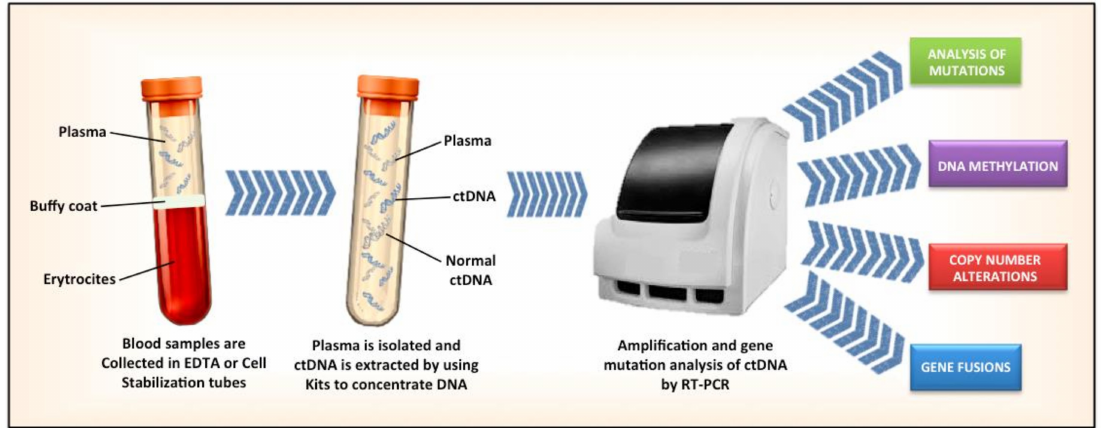
Figure 1. Steps in the isolation of cell tumor DNA in the